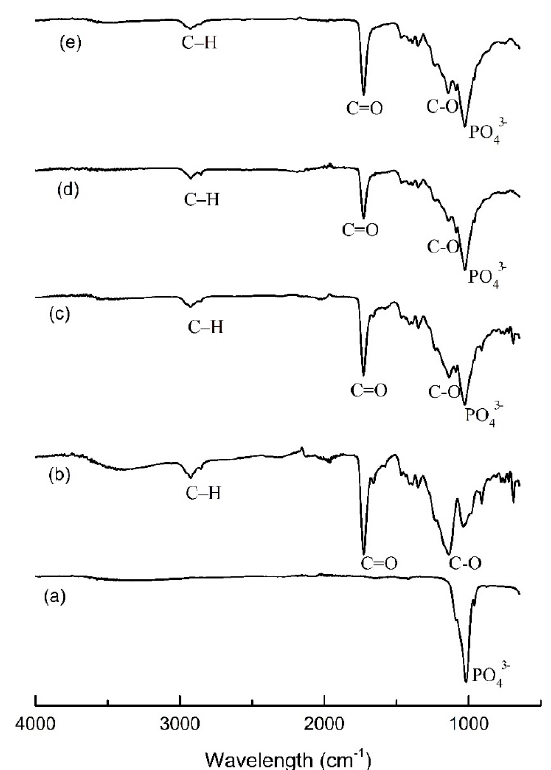
Figure 6. FTIR spectra. ( a ) Hydroxyapatite (HA); ( b ) Poly(TT / DPEHA)HIPEs; ( c ) 5-HA HIPEs; ( d ) 10-HA HIPEs; ( e ) 15-HA HIPEs.